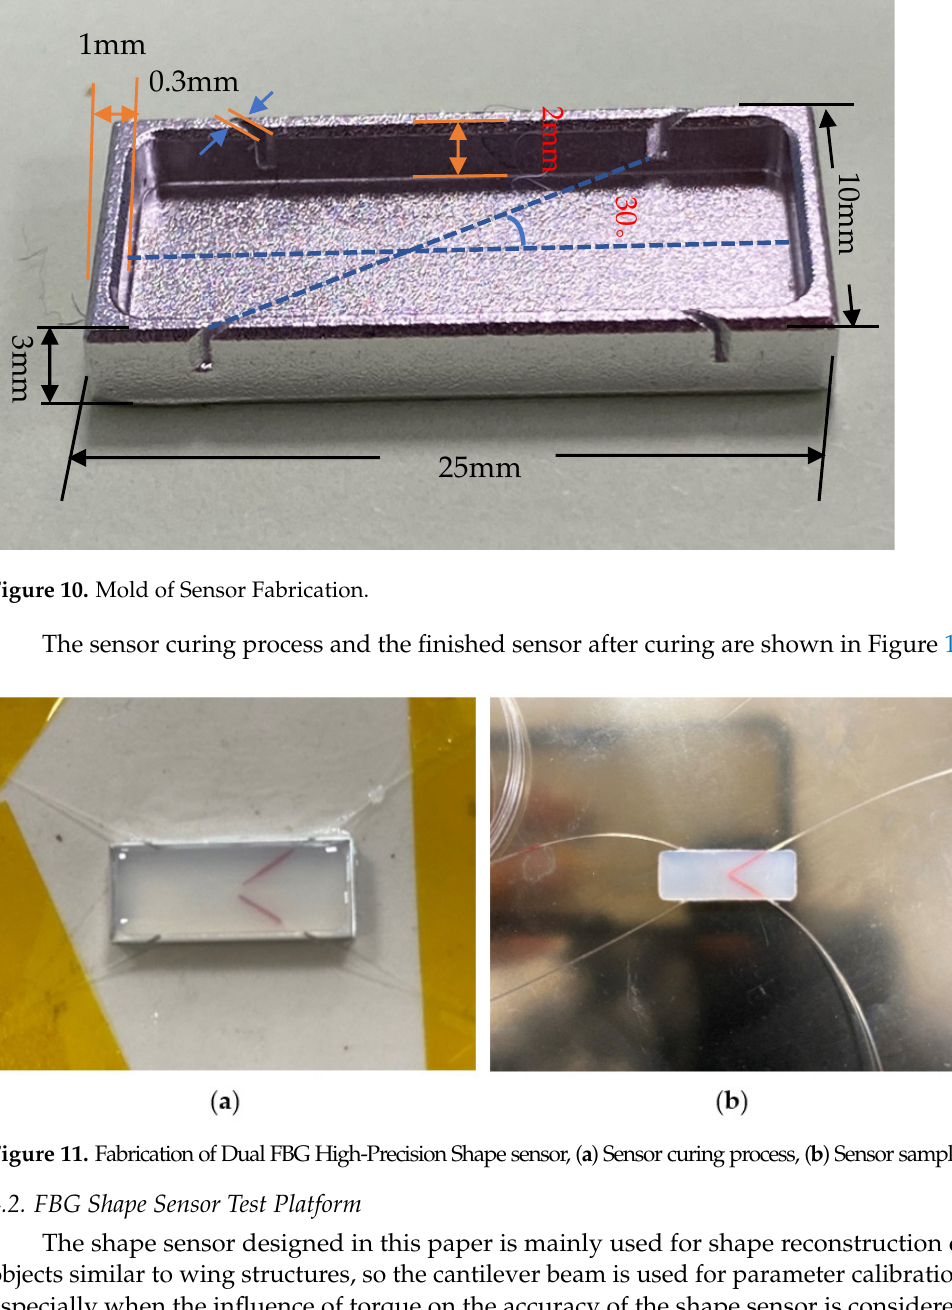
Figure 12. Dual FBG High-Precision Shape Sensor Test Platform. The material of the beam is stainless steel, the length of the beam is 500 mm and three types of sensors are attached at 200 mm from the fixed end of the beam: Single FBG silica gel shape sensor (labeled FBG2) on the left, bare FBG (labeled FBG1) in the middle and dual FBG silica gel shape sensor (labeled FBG3/FBG4) on the right. The pa- rameters of all FBGs are shown in Table 8